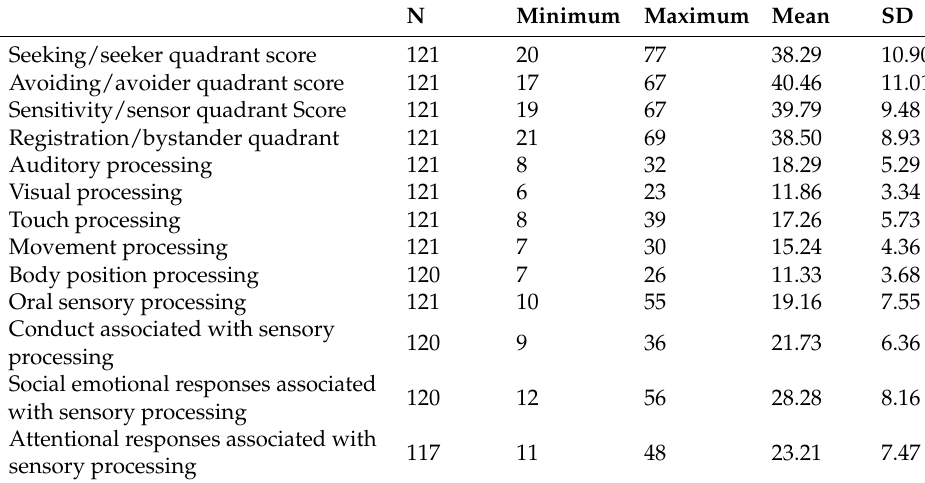
Table 4. Sensory profile results for the children.